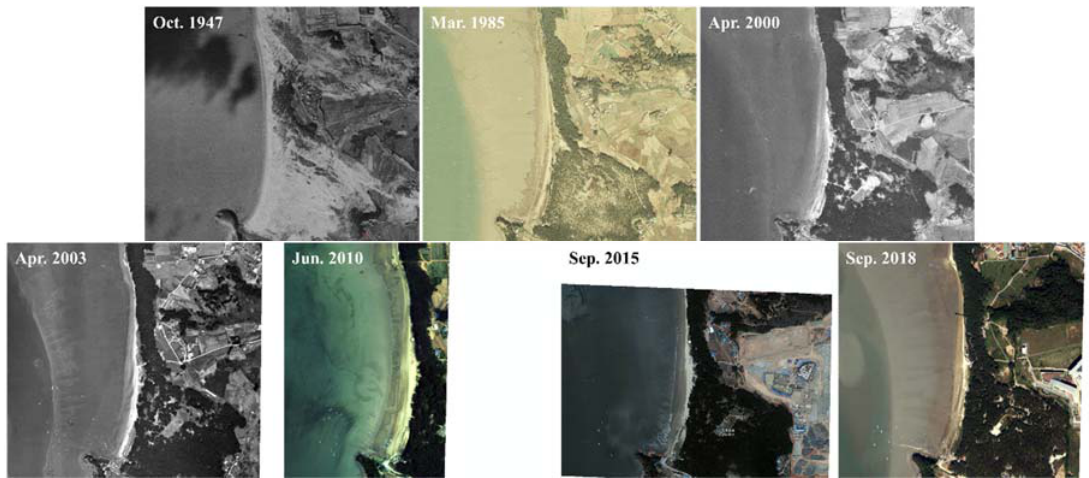
Figure 14. Aerial photograph of georeferenced Janghang Beach.